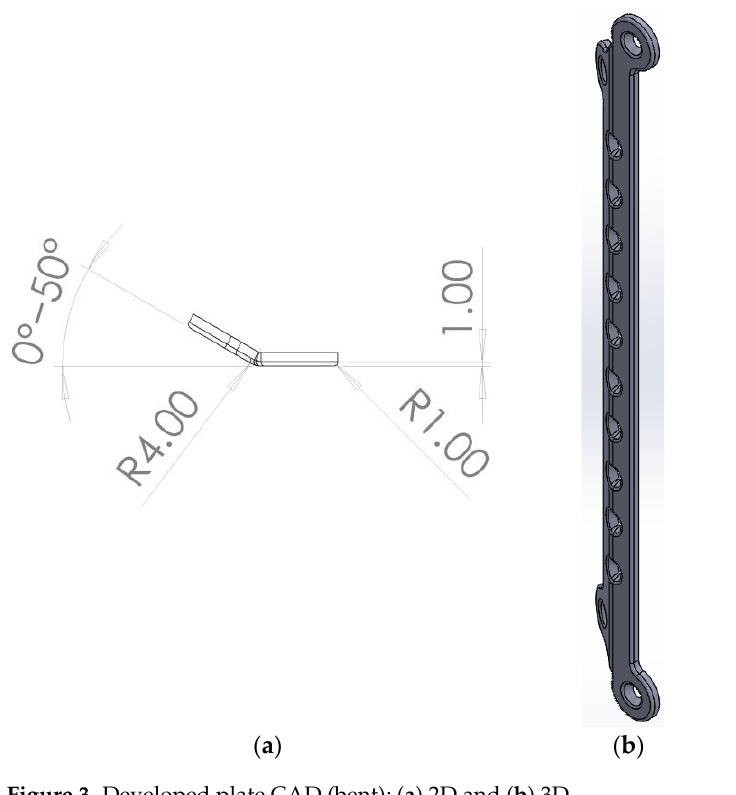
Figure 3. Developed plate CAD (bent); ( a ) 2D and ( b ) 3D.